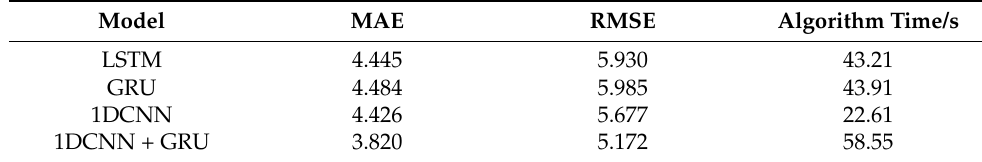
Table 4. Toll station 3 model comparison results.